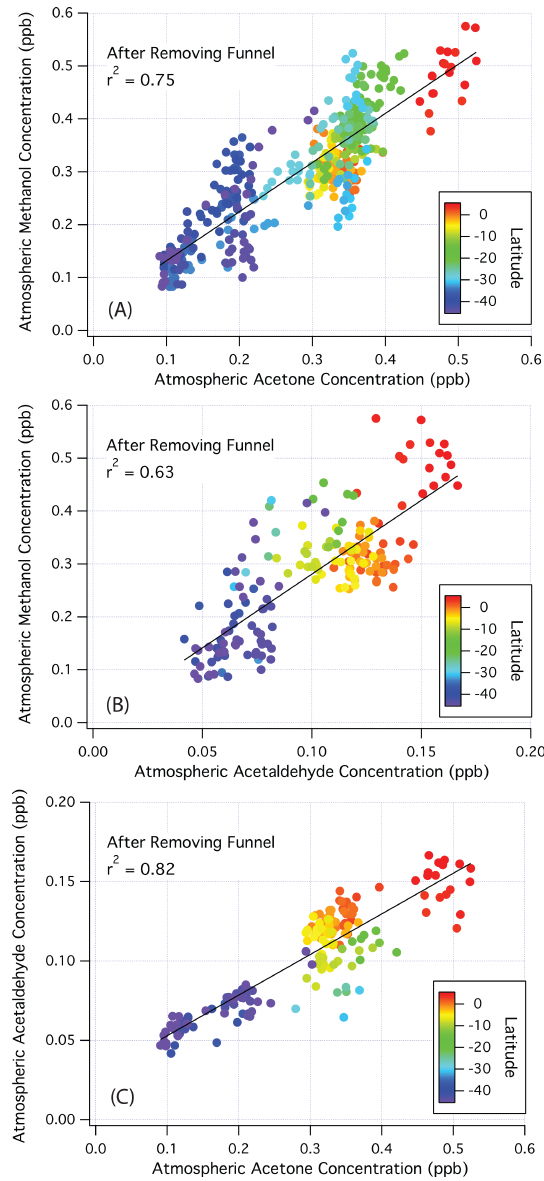
Figure 11. Atmospheric concentrations of (A) methanol vs. ace- tone, (B) methanol vs. acetaldehyde (B) , and (C) acetaldehyde vs. acetone after the removal of the inlet funnel, color-coded by lati- tude. The high degrees of positive correlations between these com- pounds and their similar latitudinal distributions imply that they share some common sources and